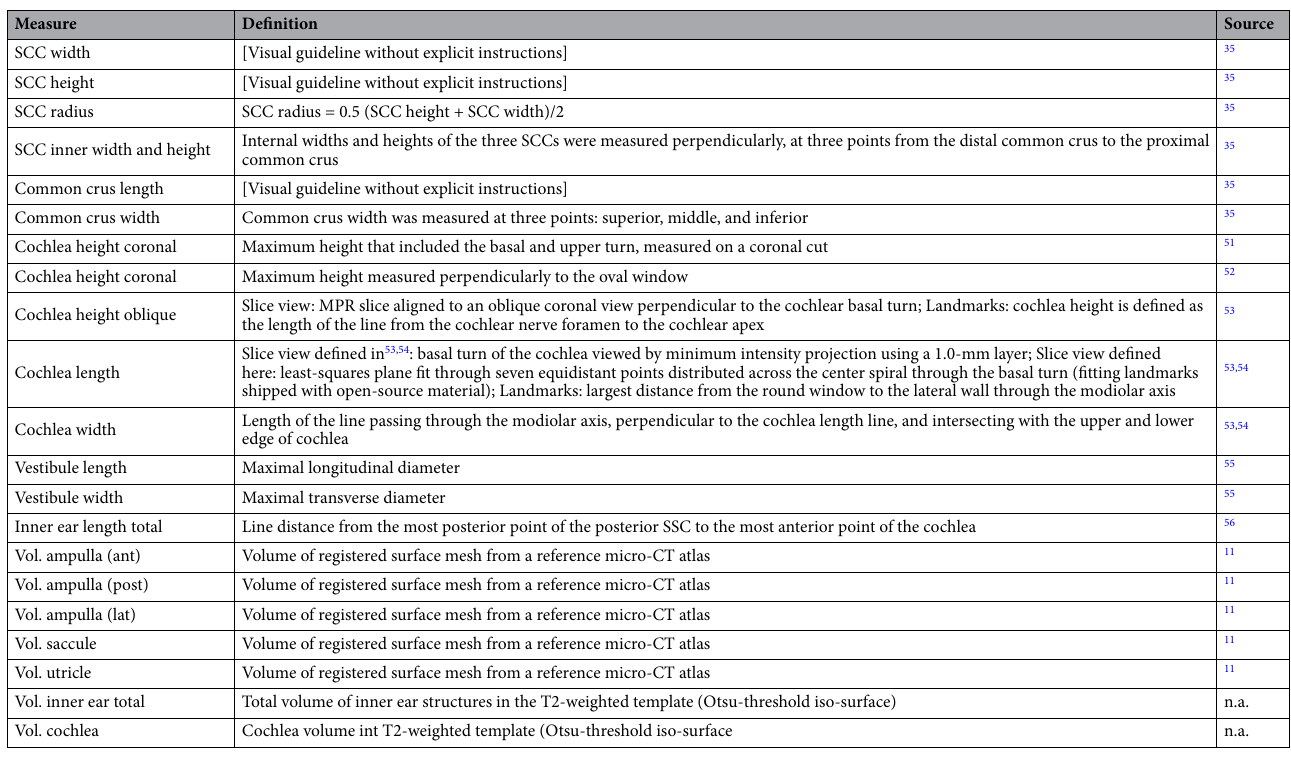
Table 2. Definitions of inner ear measures, adopted from indicated source references into IE-map (where applicable; MPR = Multi-planar reconstruction, i.e. an arbitrary slice angulation through the voxel